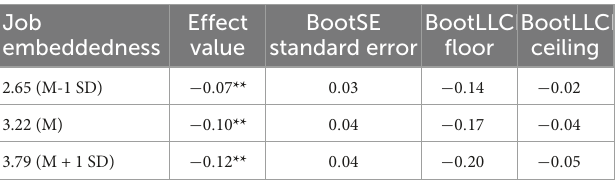
TABLE 8 Direct effects and mediating effects on different levels of job embedding. Job embeddedness